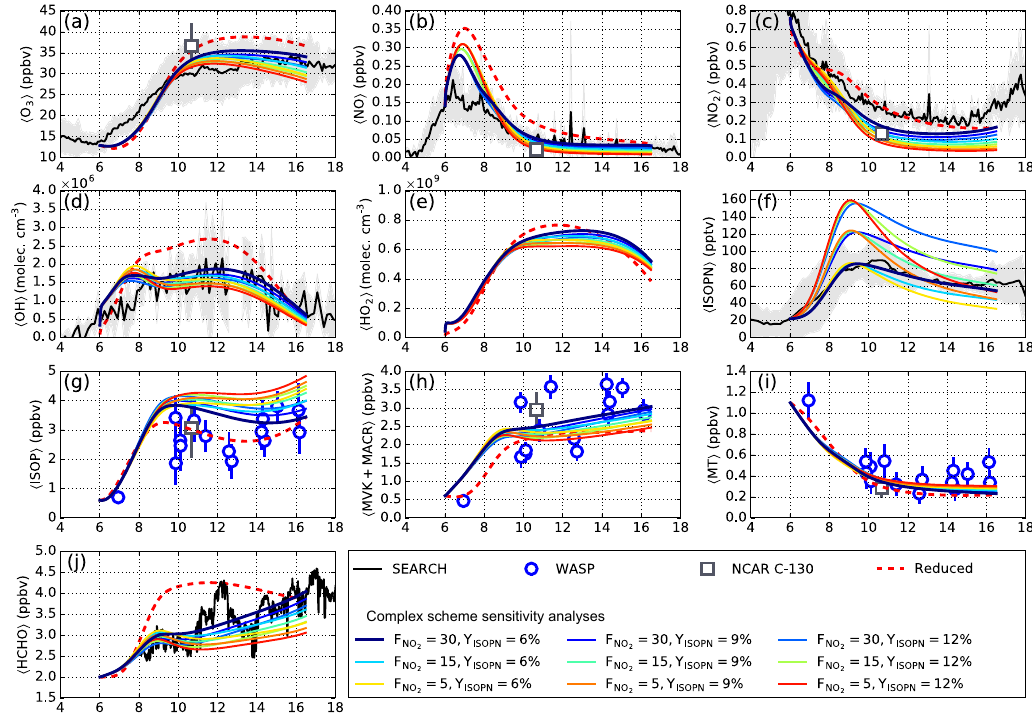
Figure 5. Diurnal variation in (a) O 3 , (b) NO, (c) NO 2 , (d) OH, (e) HO 2 , (f) ISOPN, (g) isoprene, (h) MVK + MACR, (i) monoterpenes, and (j) HCHO. The solid black line and corresponding shaded light-gray area indicate the averaged value and 1 standard deviation from the observations at the SEARCH site. The solid blue circle and corresponding error bar indicate averaged value and 1 standard deviation of VOC mixing ratios within the boundary layer from each RF of the WASP system. The solid black square and corresponding error bar indicate averaged value and 1 standard deviation of chemical species within the boundary layer from RF of the NCAR C-130 aircraft. The solid black and red lines indicate the output from MXLCH model simulation with reduced and complex chemistry schemes, respectively. Data from the WASP system are from different days and RFs; see text for